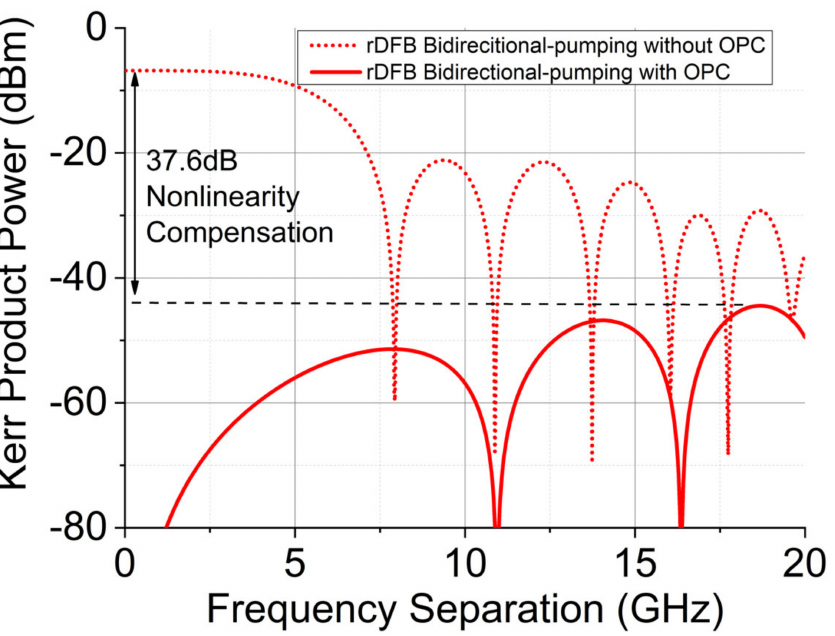
Figure 11. Theoretical predication of nonlinear Kerr product power as a function of frequency separation between the two CW lasers using rDFB bidirectional-pumping Raman amplification over 62 km SSMF